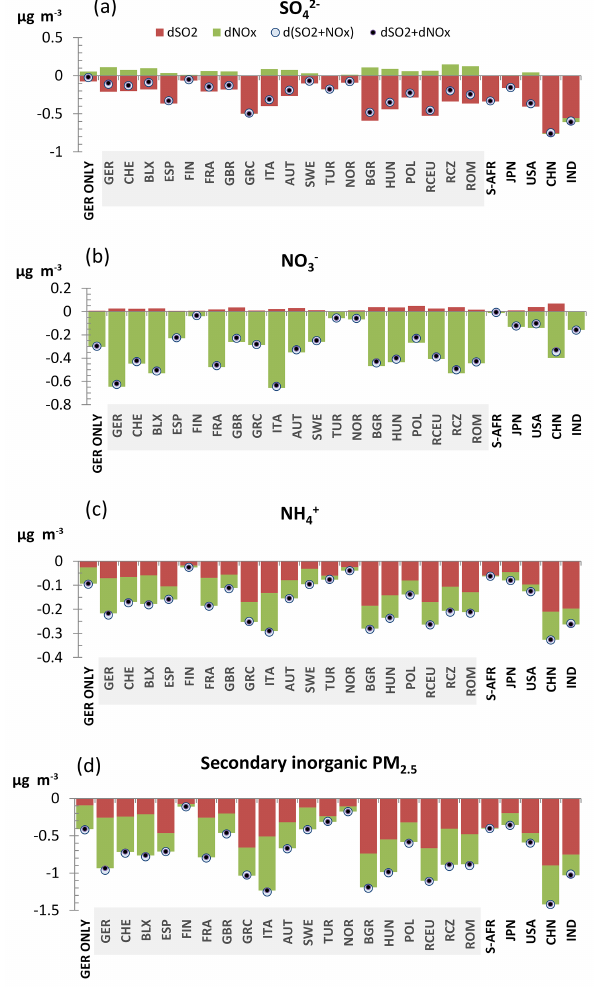
Figure 2. TM5 CTM response in annual population-weighted mean sulfate (a) , nitrate (b) , ammonium (c) , and total inorganic secondary PM 2 . 5 (d) (as a sum of the three components) upon emitted pre- cursor perturbation of − 20% for selected source regions (see Ta- ble S2.2 for the region code legend). Only the concentration change inside each source region is shown. Red bars show SO 2 -only per- turbation (simulation P2); green bars show NO x -only perturbation (simulation P3). Open circles show simultaneous (SO 2 + NO x ) per- turbation (simulation P1). Black dots show P2 + P3. Shaded regions are perturbed simultaneously as one European